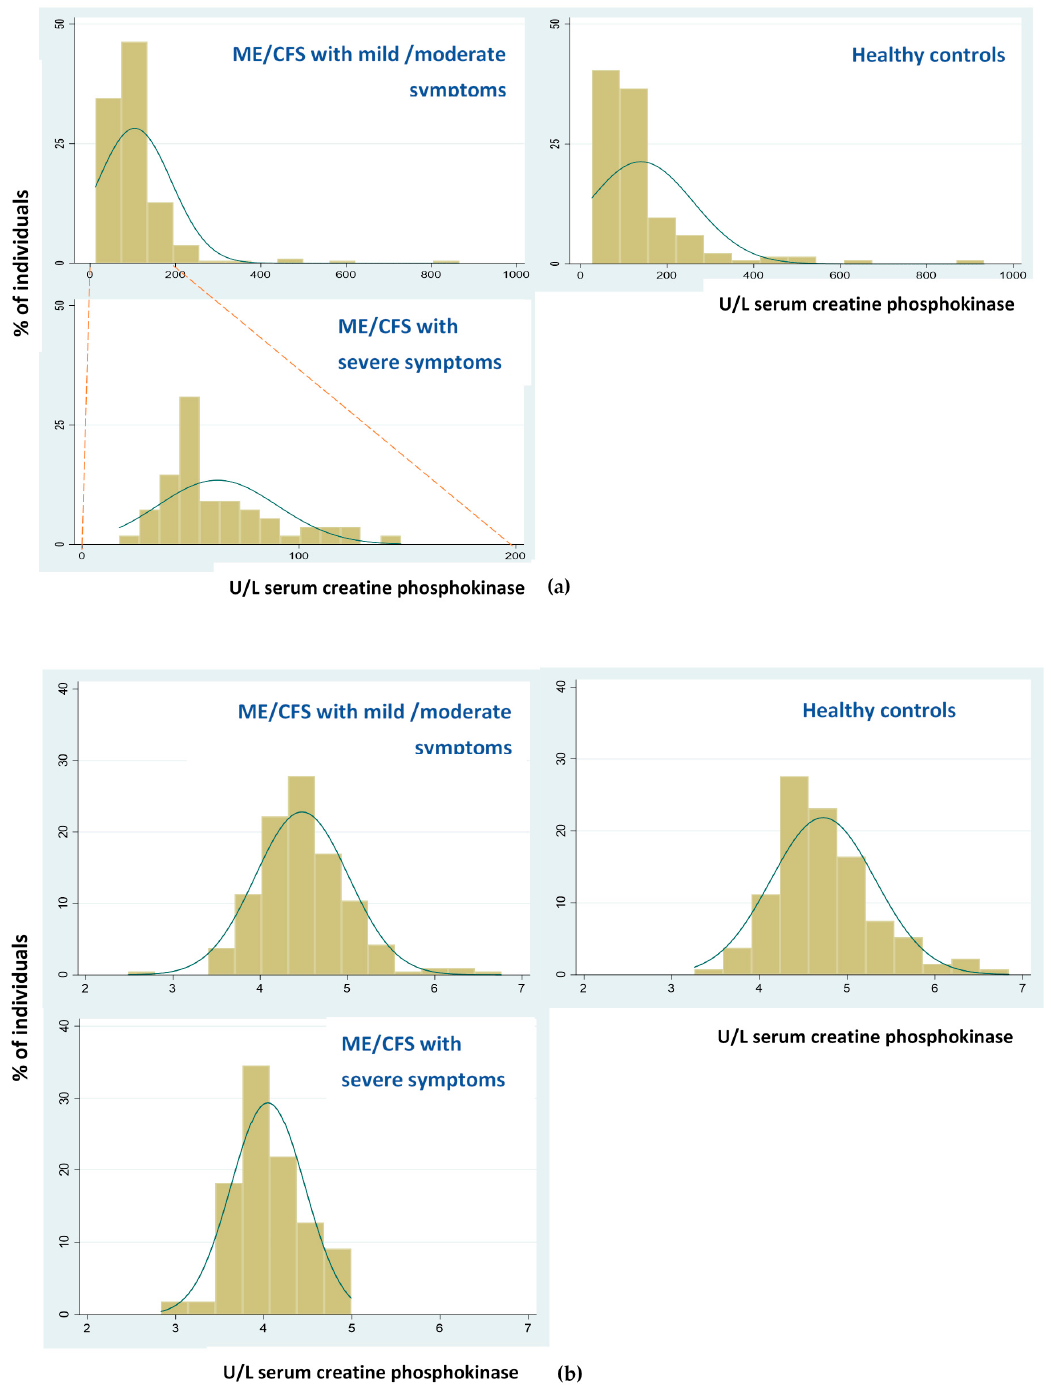
Figure A1. Histograms of serum creatine phosphokinase (CK) results from the UK ME / CFS Biobank participants, by category of recruitment. ( a ) Distribution of CK results (U / L); ( b ) Distribution of transformed lnCK.